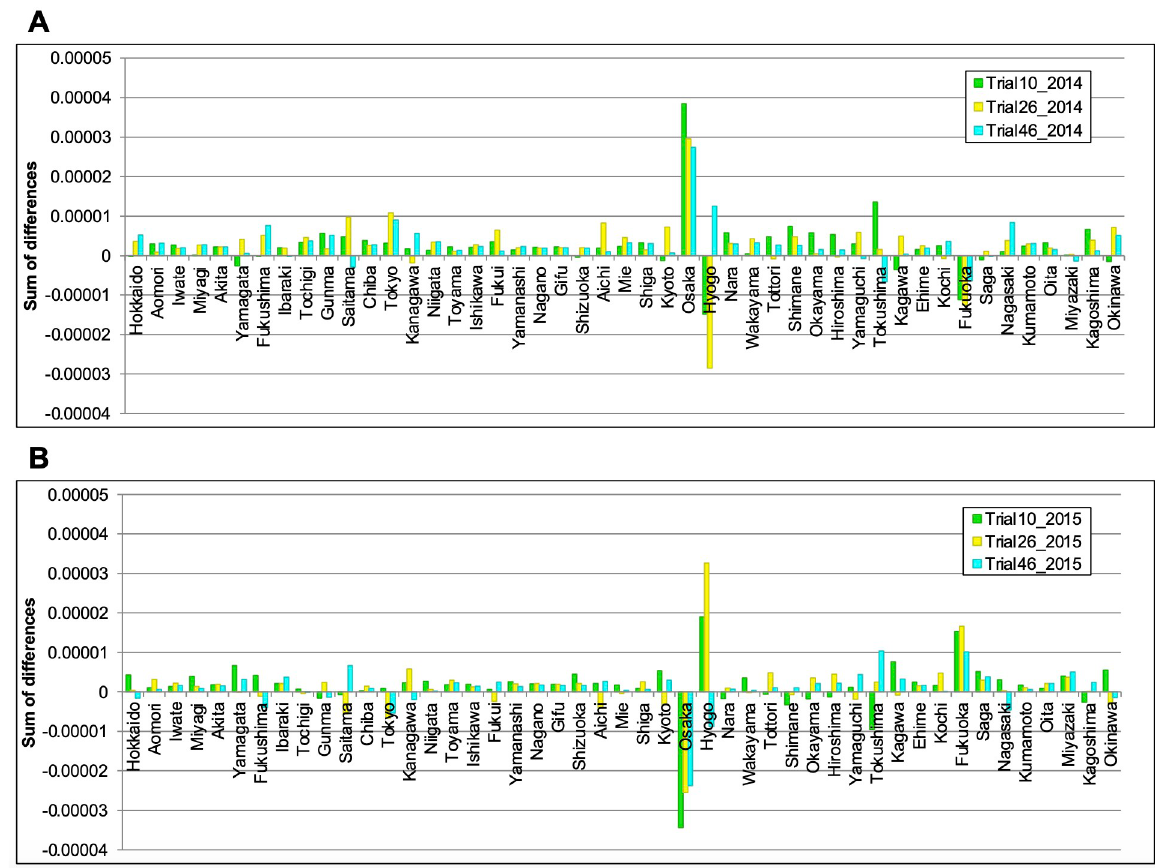
Fig 7. Size of influence of each prefecture’s epidemic against the HFMD outbreak of 2015. (A) and (B): Summed differences (weeks 9–31) between the simulation results before and after modifying the 2014 and 2015 data,